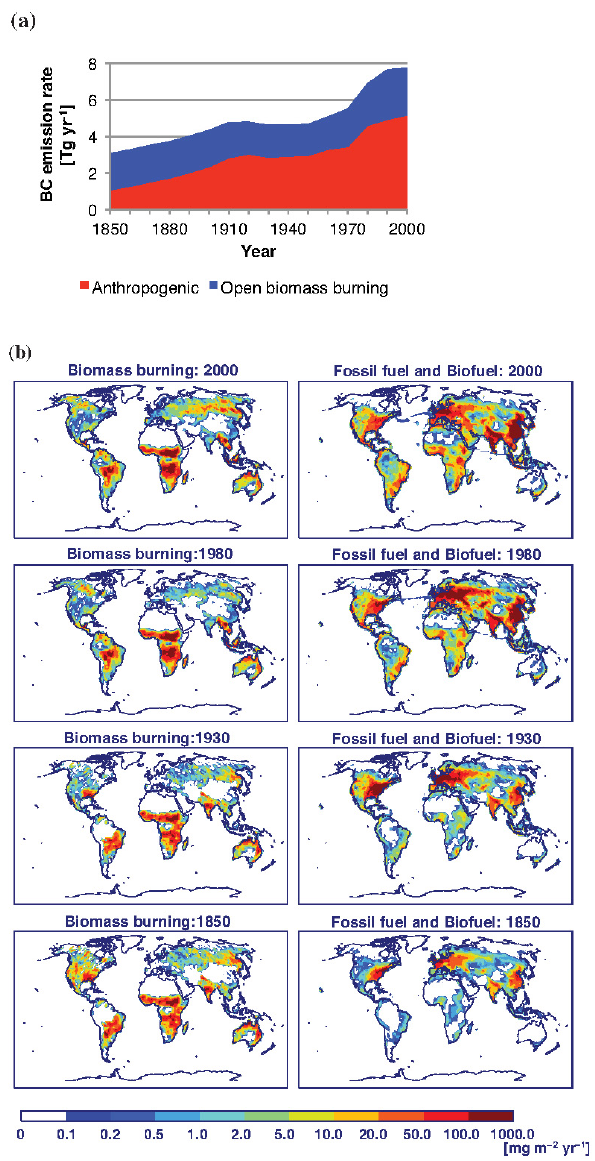
Fig. 1. Annual BC emission rate from 1850 to 2000. (a) is the global annual emission rate for anthropogenic and open biomass burning, and (b) is its spatial distributions in 1850, 1930, 1980, and